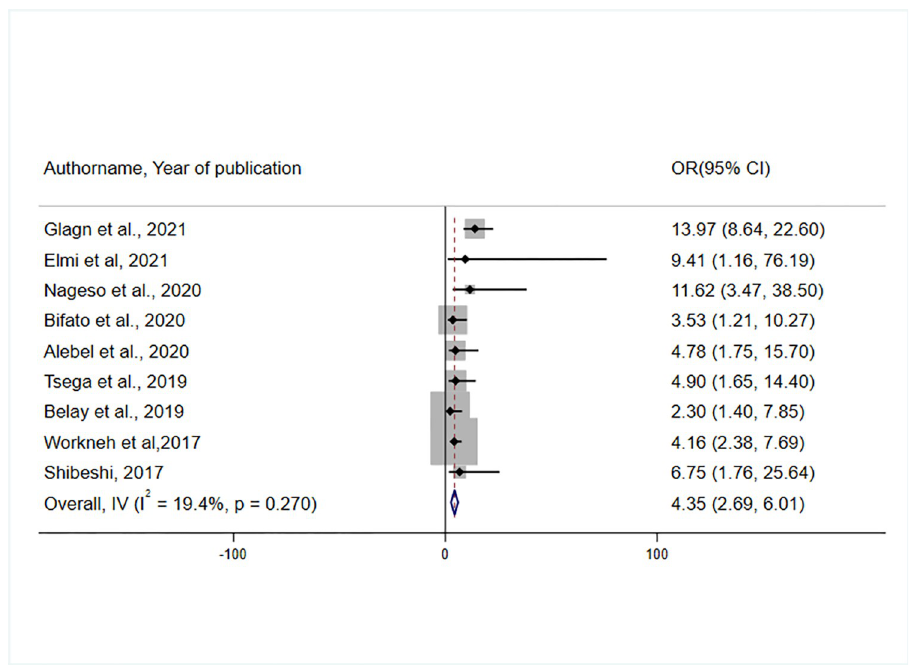
Fig 8. Forest plot showing the association between knowledge of CBHI scheme in CBHI enrolment in Ethiopia, 2017–2022.